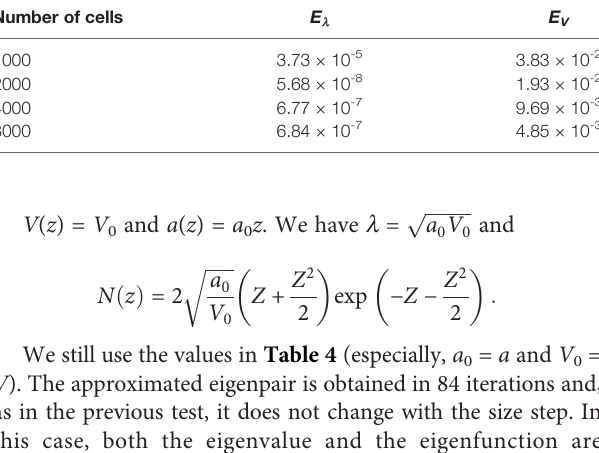
TABLE 5 | Binary division kernel: errors for several number of grid points. Number of cells